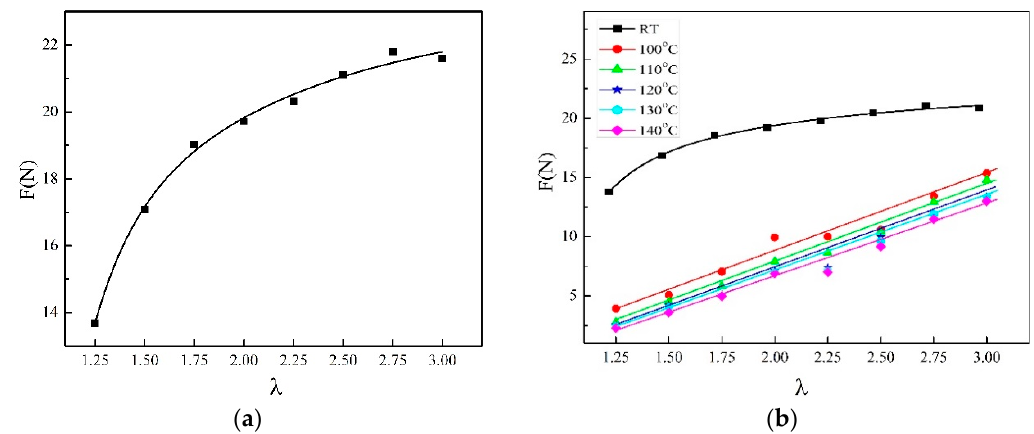
Figure 8. Tensile force of γ -PA1010 with different draw ratios. ( a ): RT; ( b ) different temperature.